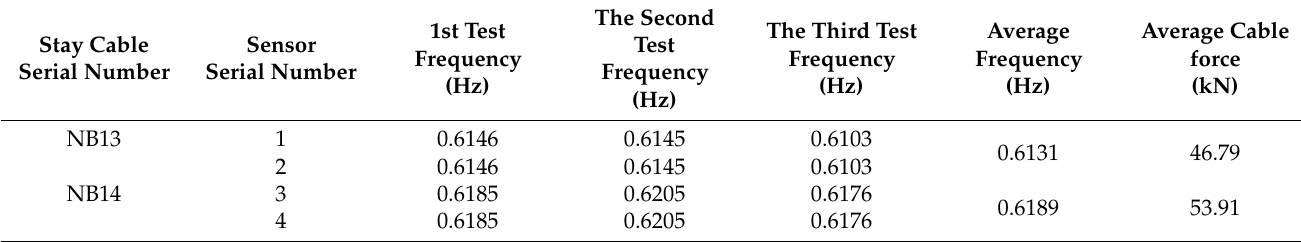
Table 3. Frequency test results under natural excitation.